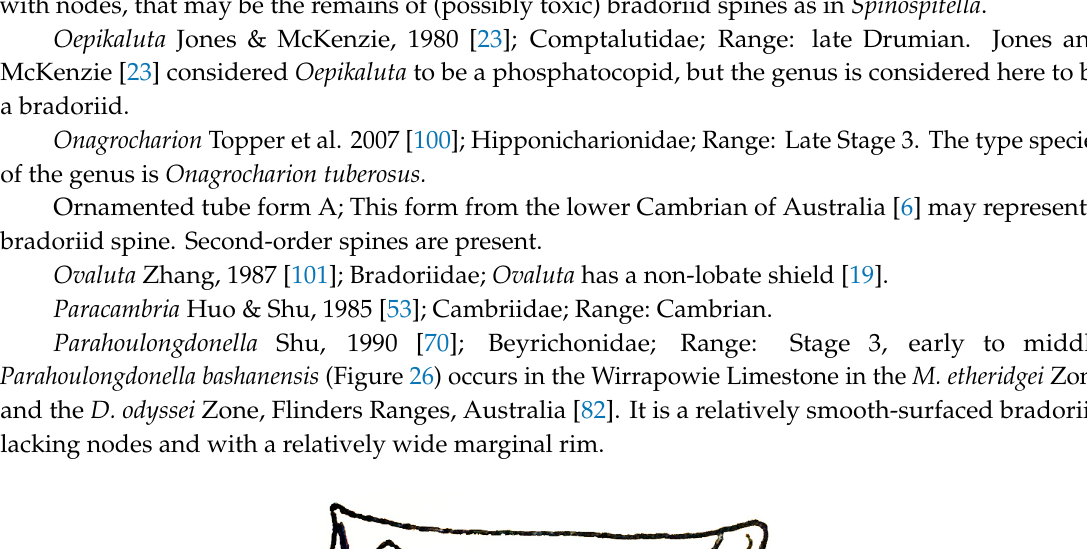
Figure 25. Neokunmingella moroensis . Anterior to left. Scale bar 200 microns. Abbreviations: a,